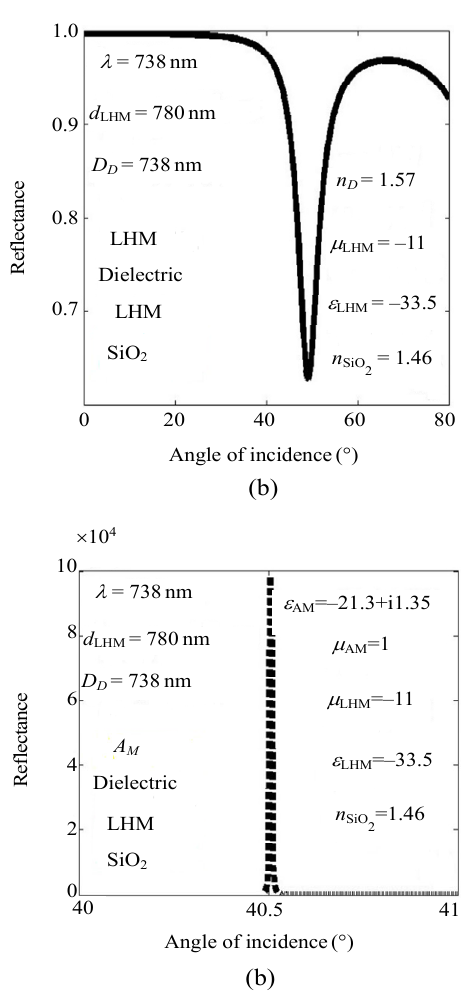
Fig. 2 Calculated angular P-reflectance spectra investigated from the samples: (a) prism-LHM layer- dielectric gap layer-LHM bulk, and (b) prism-LHM-dielectric gap layer-Au bulk. The parameter conditions are specified in the inset of the